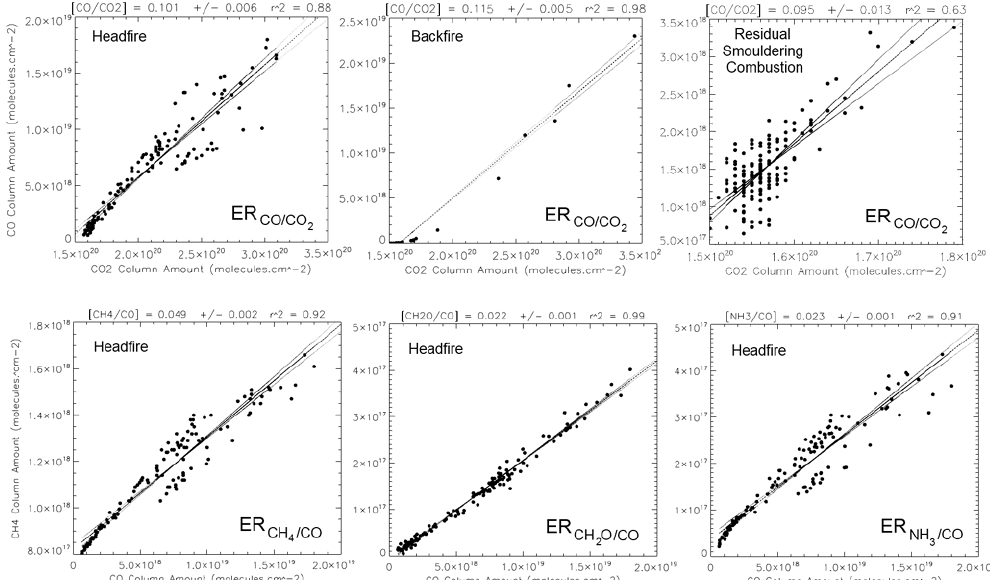
Fig. 7. Example 2-D scatterplots of the measured trace gas column amounts used to calculate emissions ratios. Data are from Fire 1, whose time-series measurements are shown in Fig. 6. Top row shows the CO vs. CO 2 data for the backfire, headfire and residual smouldering combustion stages of this fire. Bottom row shows the CH 4 vs. CO; CH 2 O vs. CO and NH 3 vs. CO data for the headfire stage only. The slope of the least squares linear best fit to these data (shown, along with its uncertainty) is used to derive the relevant emission ratio (ER x / y ), whose value is shown above the relevant plot. Note the different axes scales required to accommodate the varying column amounts measured during the various fires